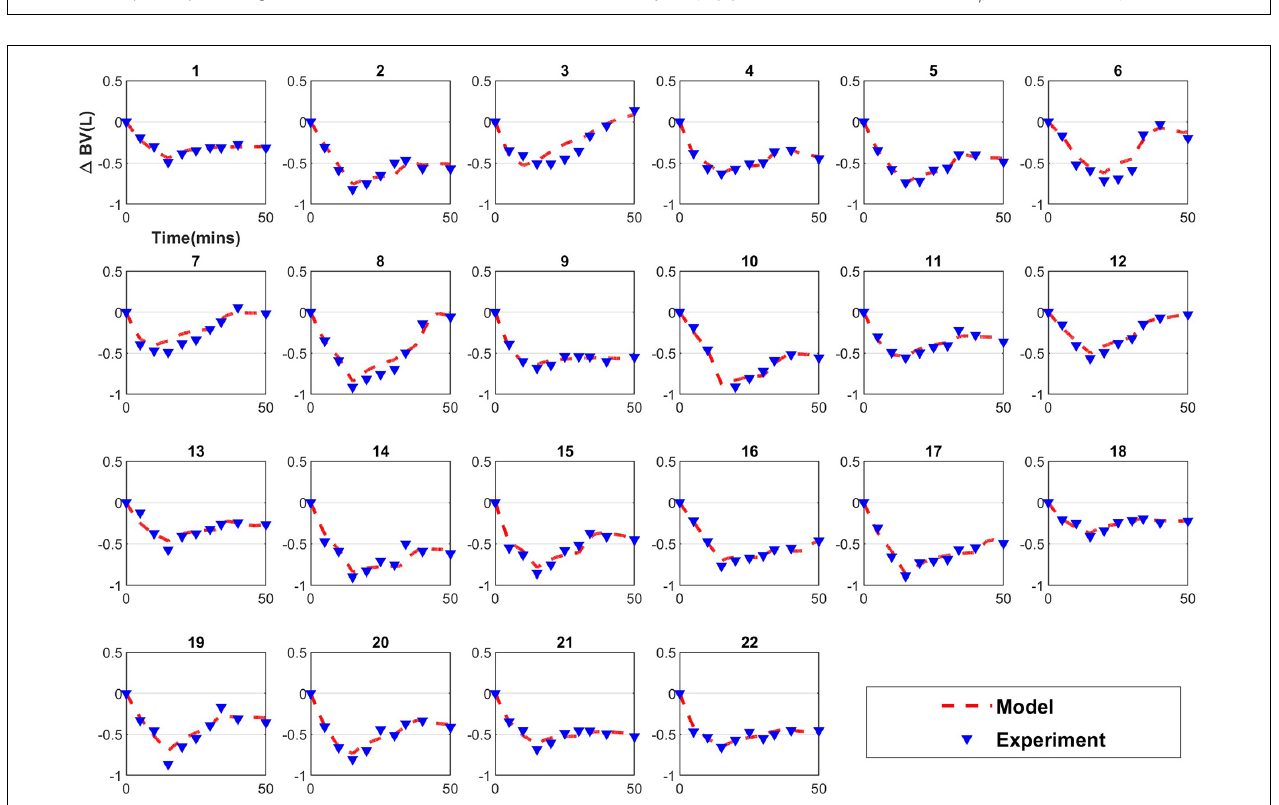
FIGURE 4 | Calibration results for the two parameter model.